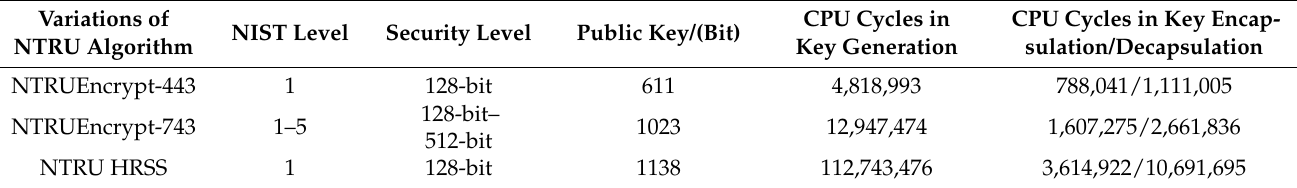
Table 2. Comparison of various encryption algorithms based on NTRU [15].